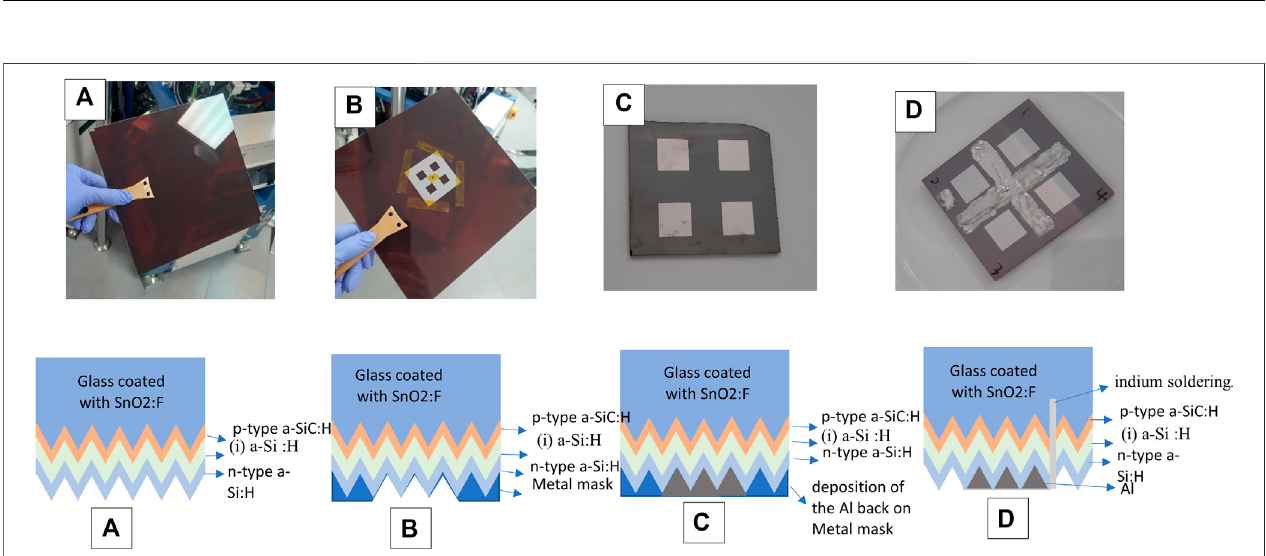
FIGURE2| Side-viewcrosssectionandstepsofthemethodofthefabricationofasinglejunctioncell: (A) depositionofthep-i-nstructureonthe20 cm 2 × 20 cm 2 SnO2:F/glass substrates, (B) fi xation ofthe metal mask on thep-i-nstructure, (C) depositionofthe Alback contact, (D) samplescutting and indium soldering to access to the front contact.